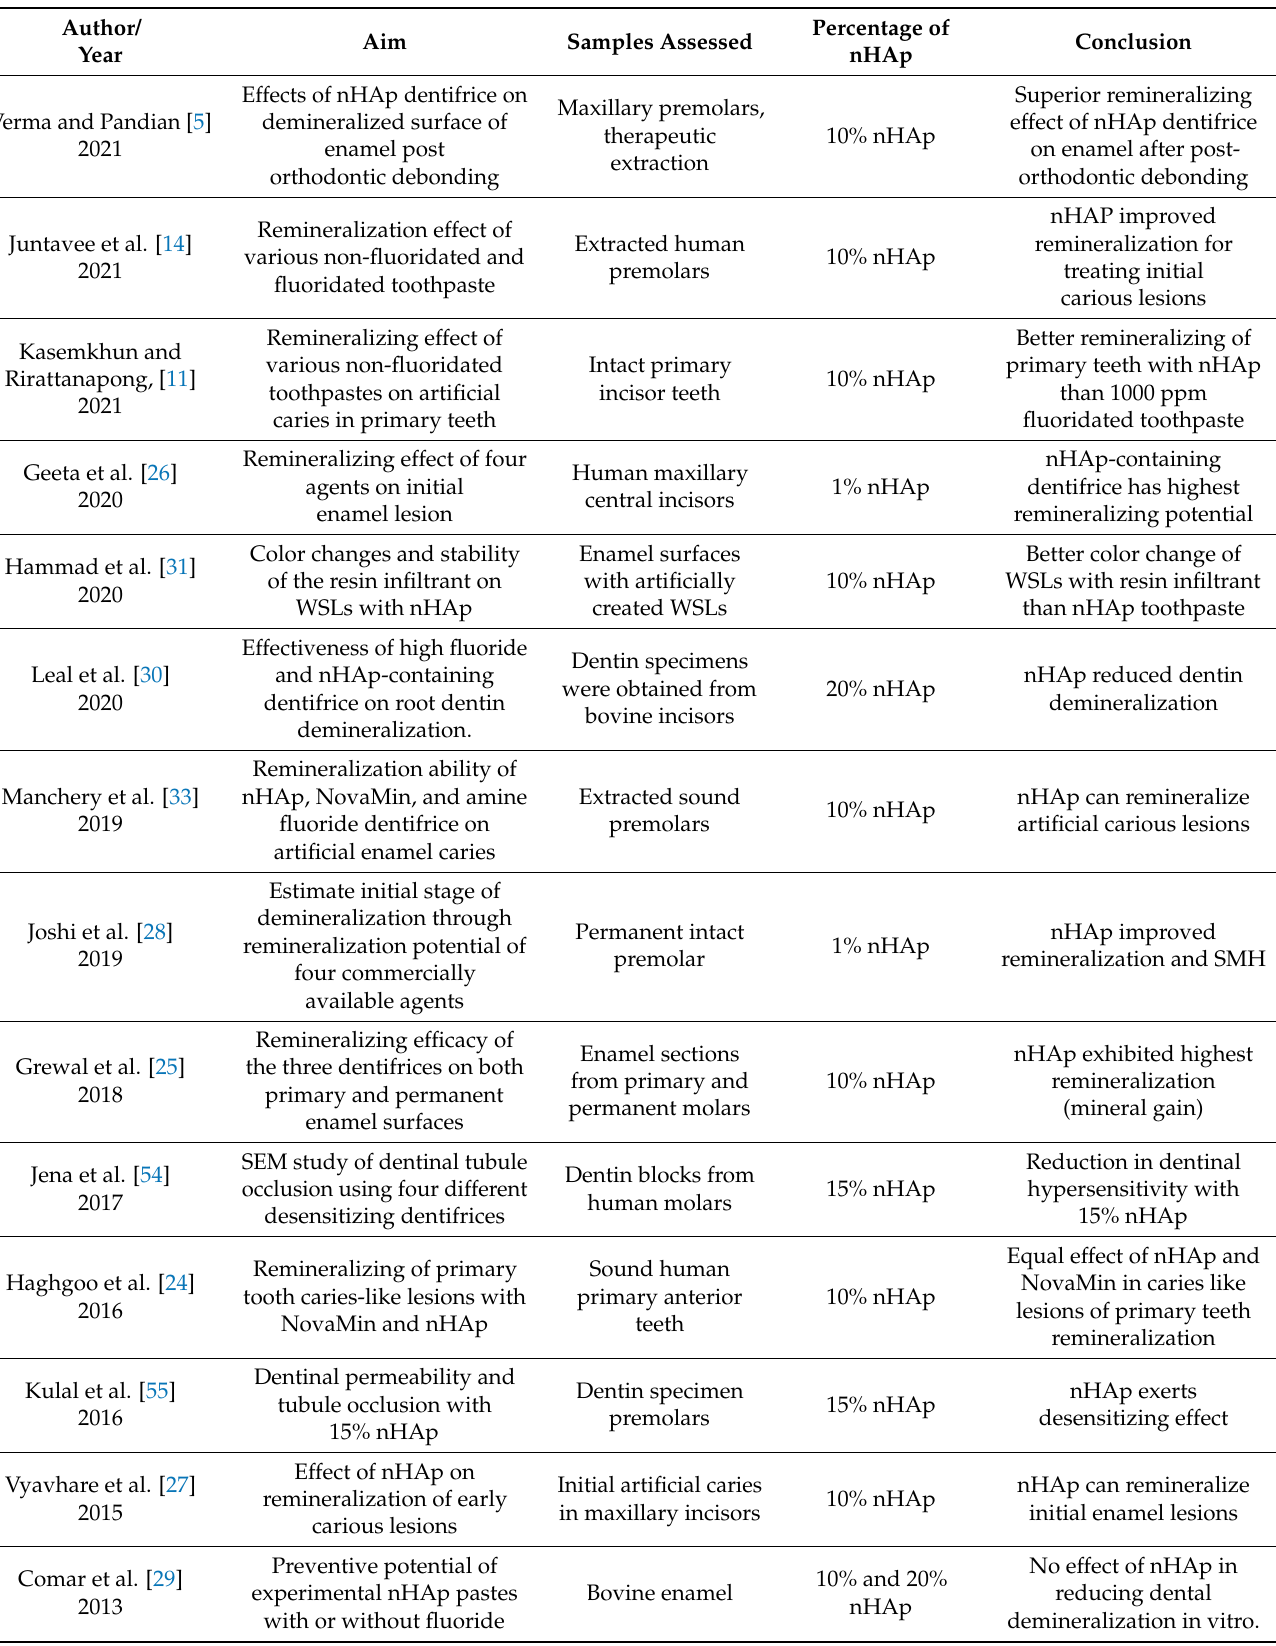
Table 2. Summary of publications that reported the effect of nano-hydroxyapatite dentifrice in in vitro